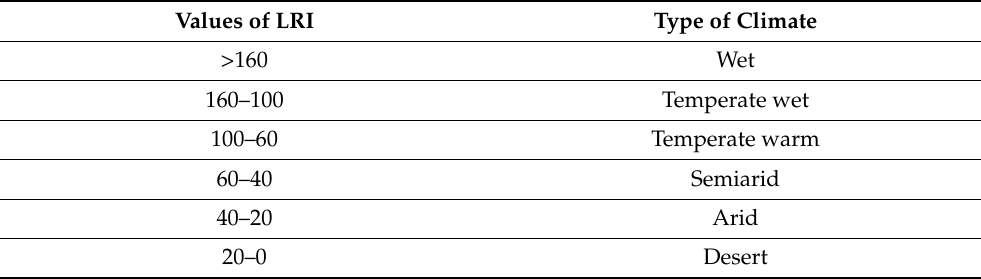
Table 2. The Lang rainfall index